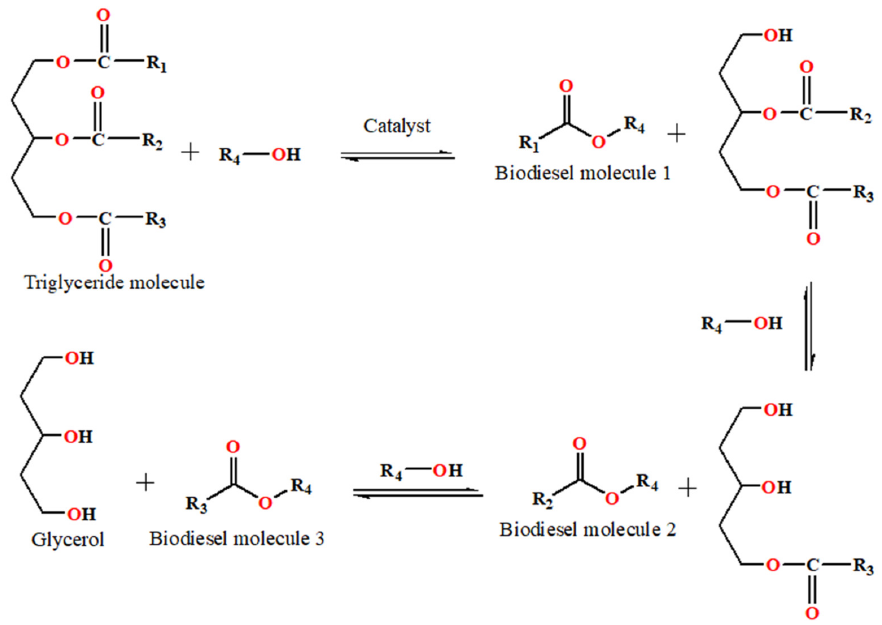
Figure 1. Three-step transesterification process.